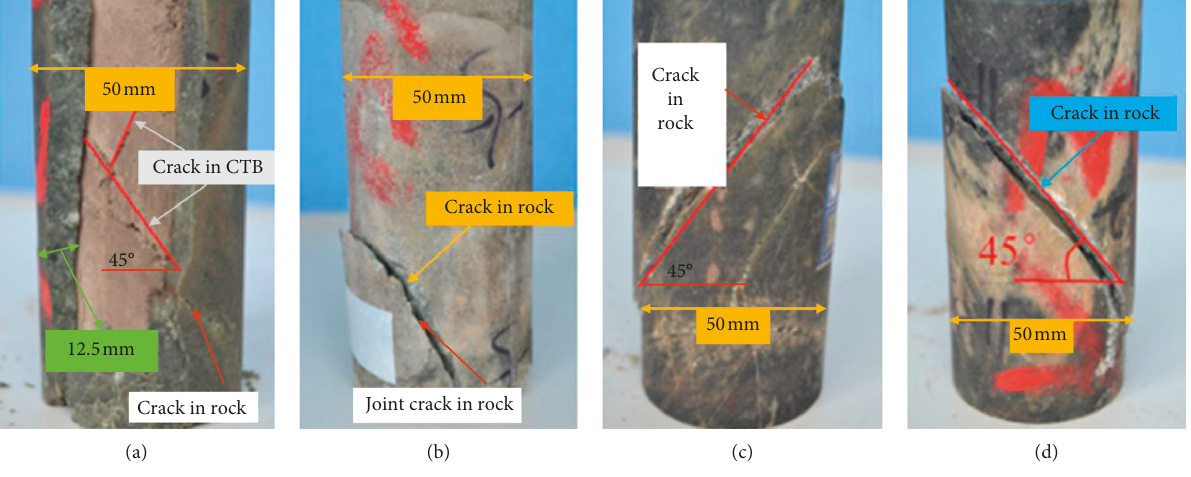
Figure 9: Failure modes of RCTMC